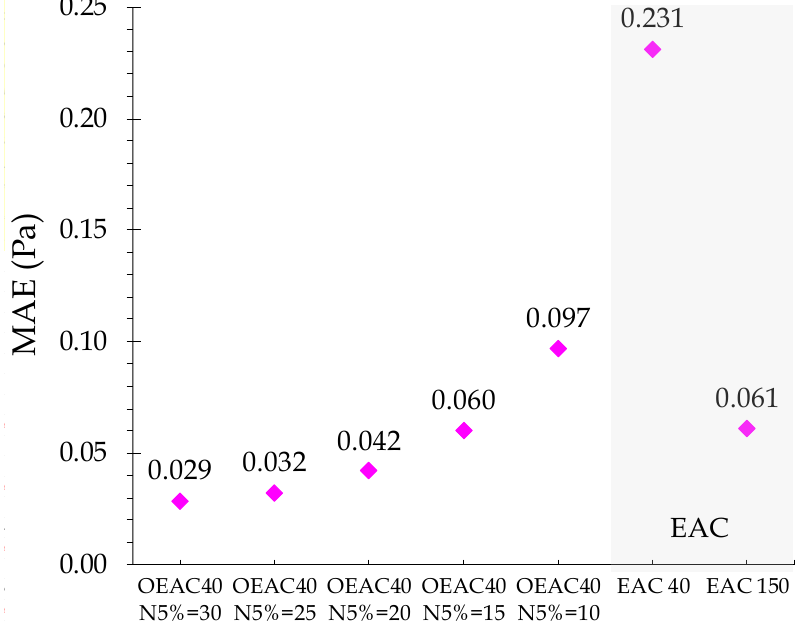
Figure 9. Mean absolute error (MAE) for the wall shear stress for different meshes.